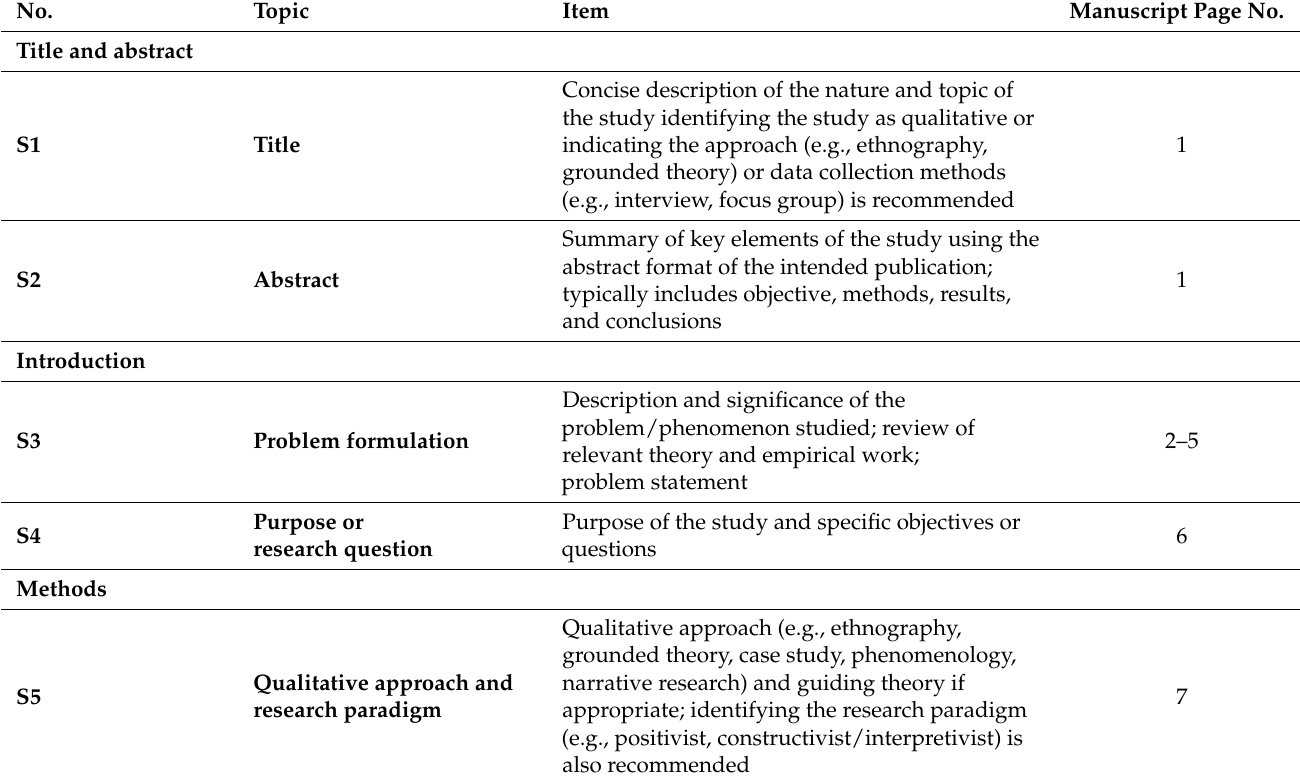
Table A1. Standards for Reporting Qualitative Research